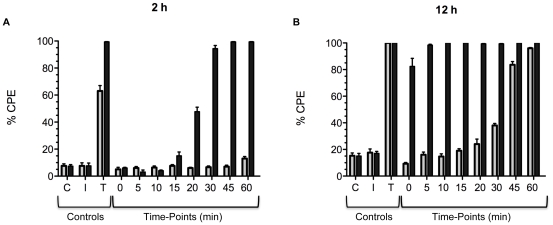
Comparison of the timing of cell entry between TcdBHV and TcdBHIST.CHO cells were pretreated with TcdBHIST or TcdBHV and the lysosomotropic inhibitor, ammonium chloride, was added at the indicated time points. Cytopathic effects were determined at 2 h (A) and 12 h (B), and black bars represent cells treated with TcdBHV while gray bars represent TcdBHIST. The error bars mark the standard deviation from the mean. C, untreated control. I, inhibitor alone. T, TcdB alone.